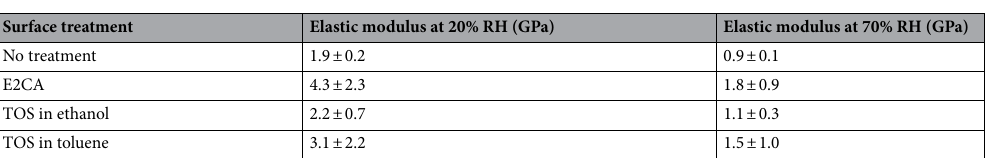
Table 2. The elastic modulus of cellulose-APP composites with various surface treatments at 20% and 70% RH; each condition was tested on five different specimens and the errors are given at 95% confidence.